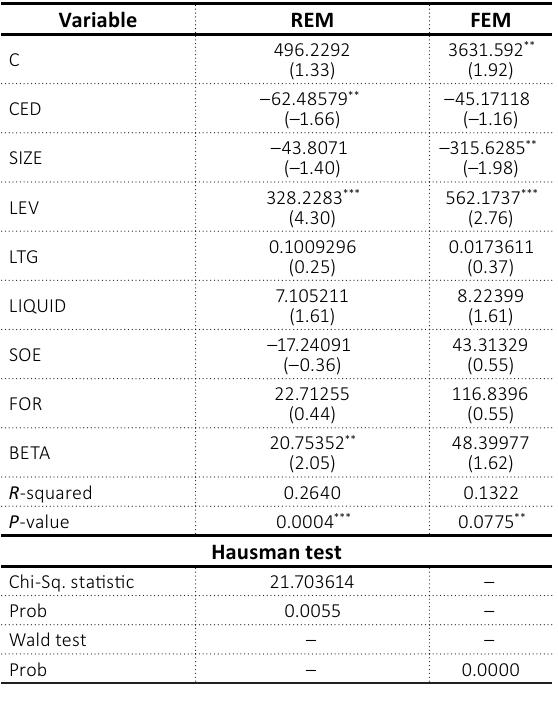
Table 6. Regression analysis results